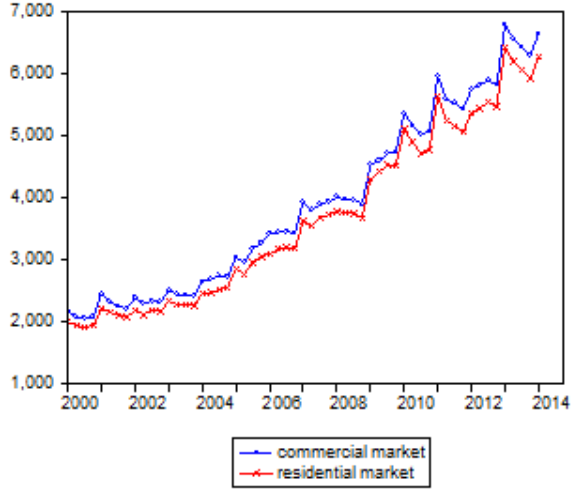
Figure 1. China’s Commercial and Residential Housing